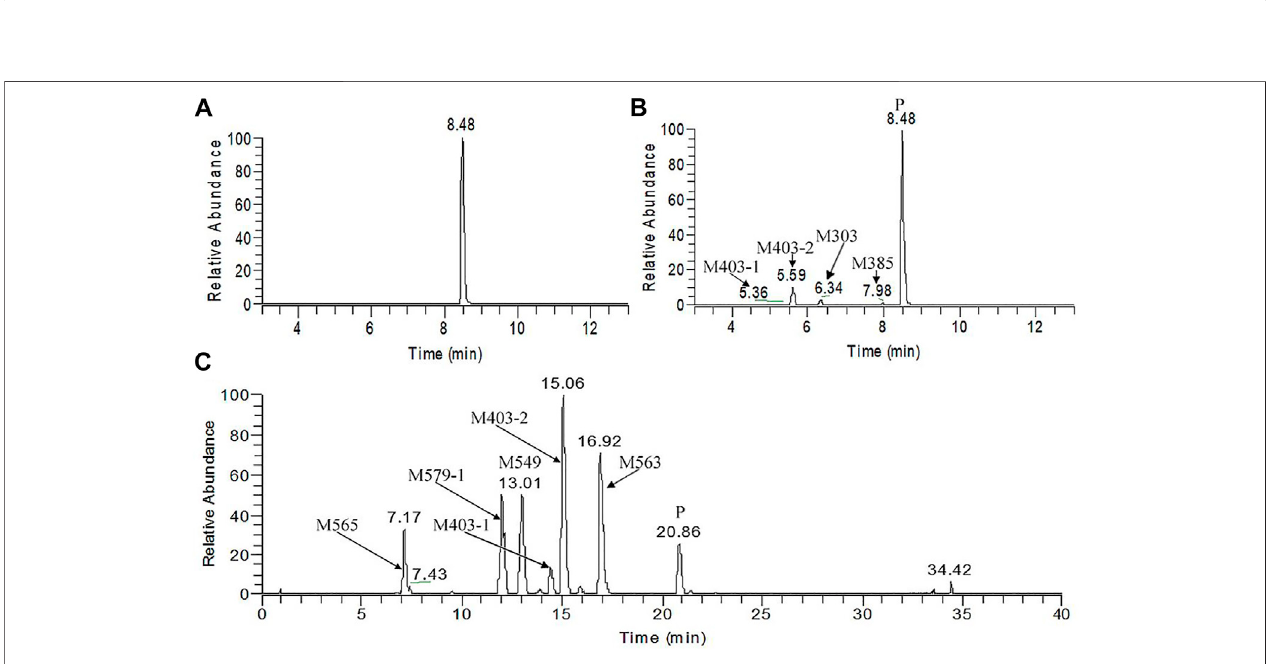
FIGURE 5 | The extracted ion chromatograms of human liver microsomes incubated without (A) and with NADPH (B) and dog plasma samples obtained after a single oral dose of (+)-9-tri fl uoroethoxy- α -dihydrotetrabenazine at 3 μ mol/kg (C) .